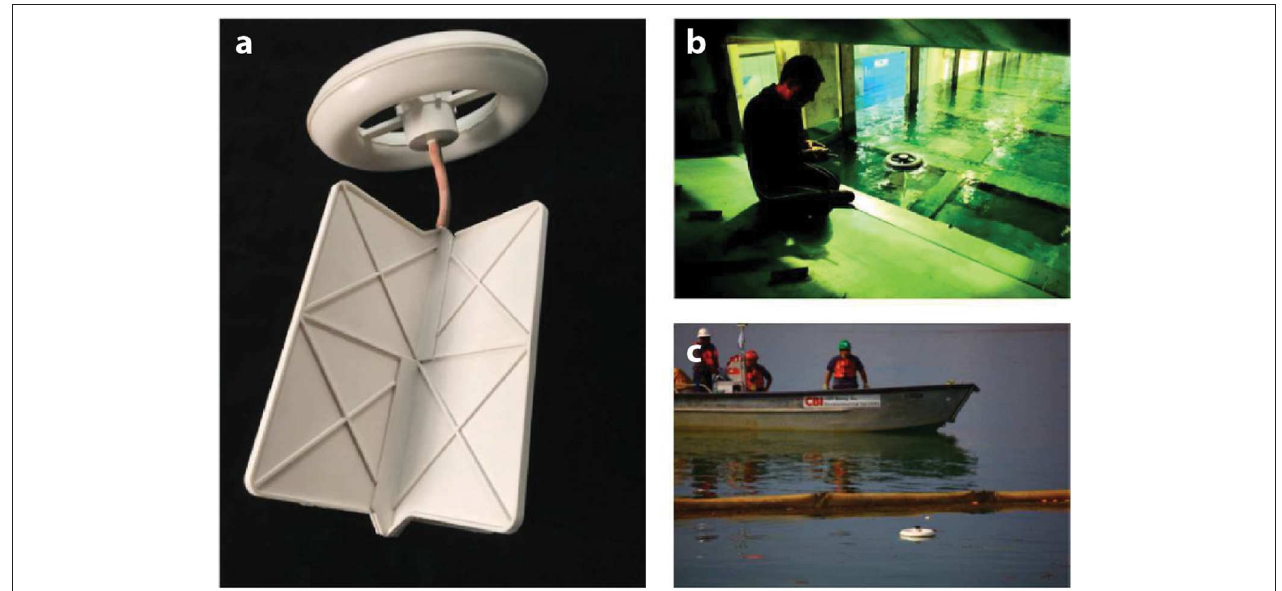
FIGURE 2 | (a) The CARTHE drifter. A surface float supports a subsurface drogue on a flexible tether. The drogue extends to 0.6 m below the surface. (b) The drifter performance was extensively tested the University of Miami wind-wave tank and (c) during oil spill exercises (from Lumpkin et al., 2017).